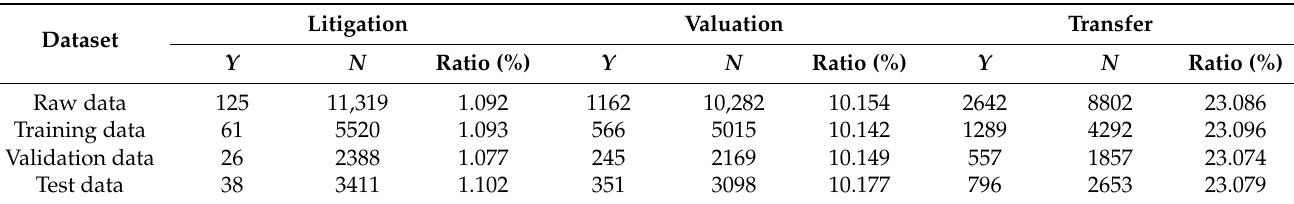
Table 3. Result of splitting the data to train the